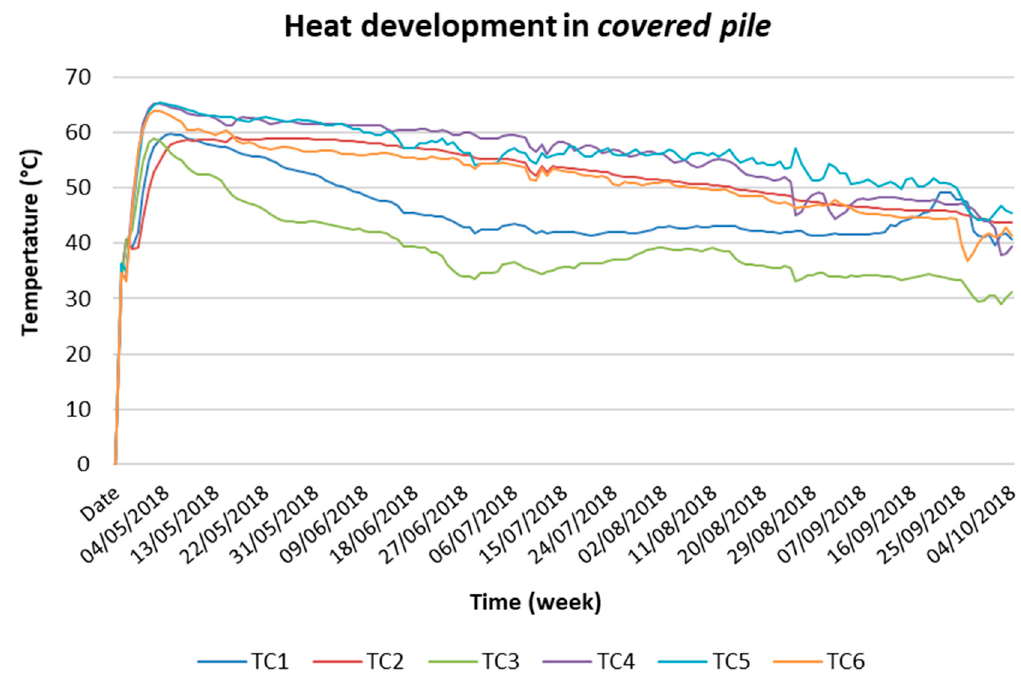
Figure 5. Heat development in covered pile. The numbered letters (TC1, TC2, etc.) indicate the thermocouple location according to the scheme shown in Figure 2.